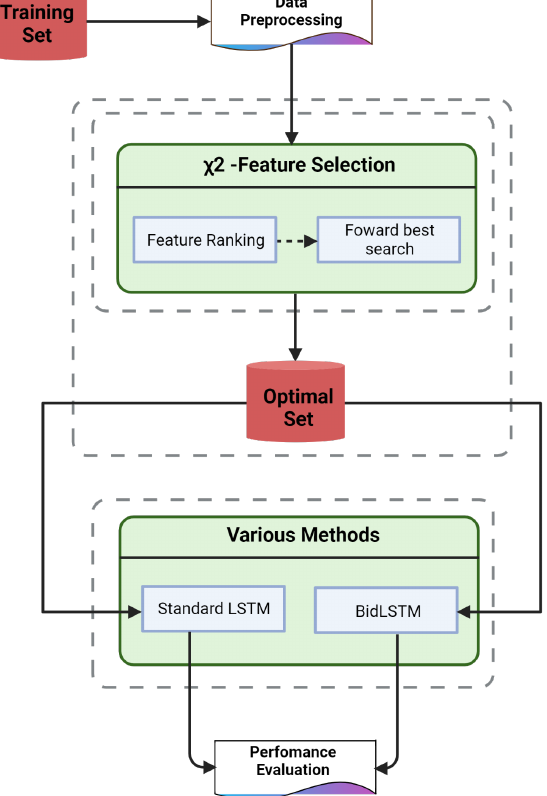
Figure 1. The proposed IDS architecture.